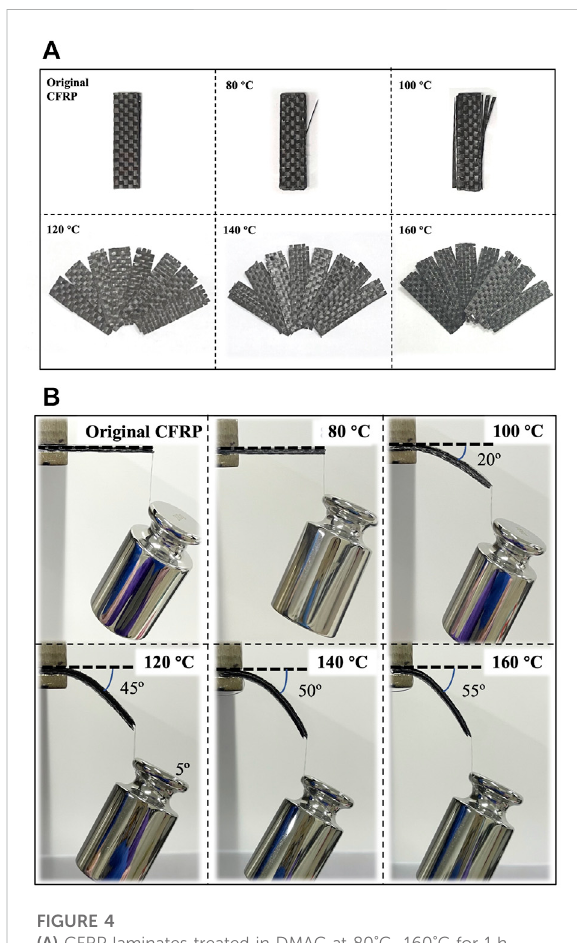
FIGURE 4 (A) CFRP laminates treated in DMAC at 80 ° C – 160 ° C for 1 h and (B) corresponding load deformation